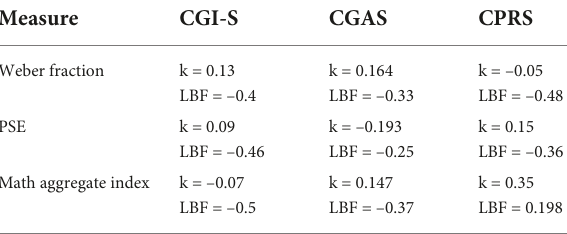
TABLE 4 Kendall’s